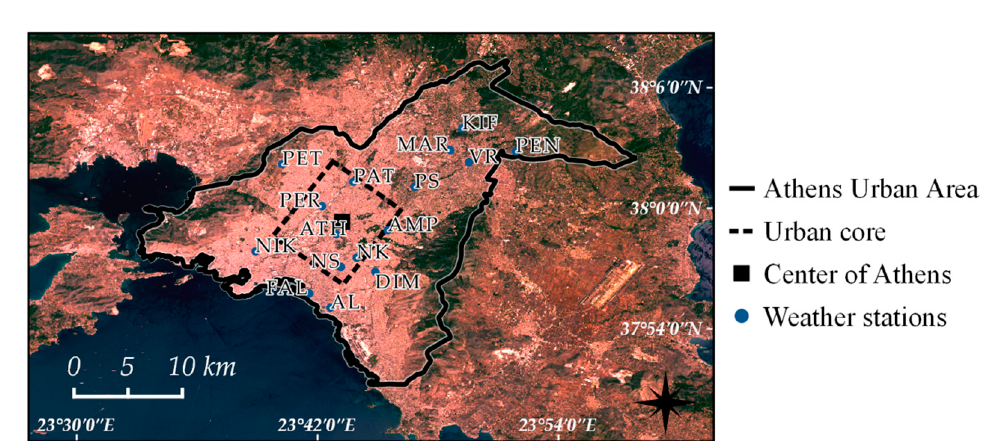
Figure 1. Location of the 25 European cities used in this study. Dashed lines indicate the Weather Research and Forecasting (WRF) simulation domains; ascending order from the lower (D1) to the higher resolution domain (D4).